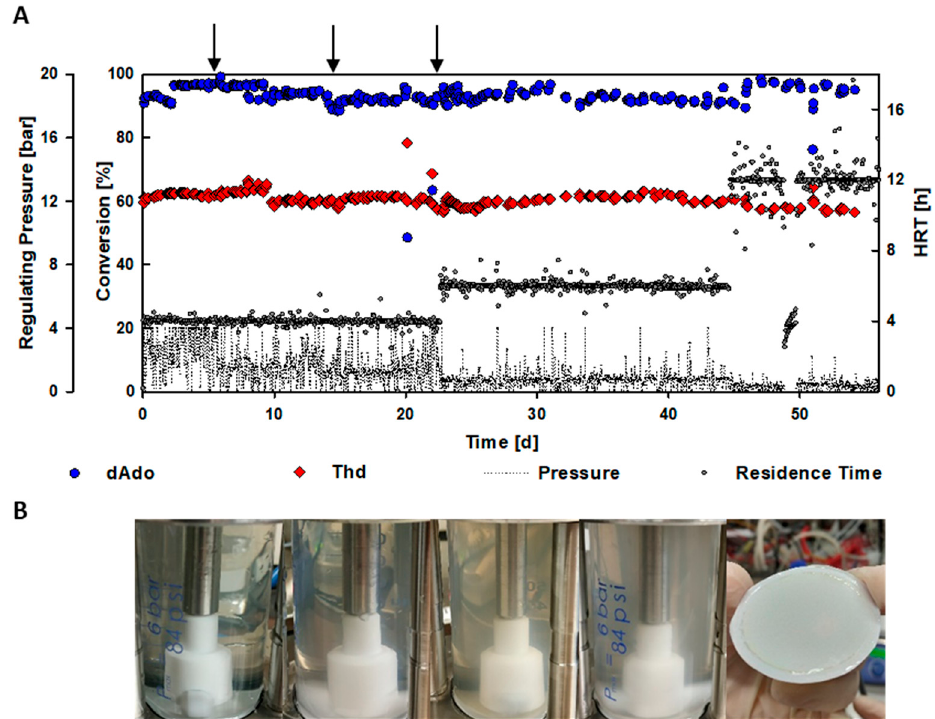
Figure 3. Continuous production of 2 ′ -deoxyadenosine from thymidine (25 mM) and adenine (10 mM) using purified nucleoside phosphorylases (150 U of PyNP 02, 1050 U of PNP 02, by BioNukleo) at 40 °C, stirred at 200 rpm. ( A ) Monitoring of thymidine (Thd) cleavage and 2 ′ -deoxyadenosine (dAdo) formation, and regulating pressure during operation, at hydraulic residence times (HRT) of 4, 6, and 12 h. Membrane exchange and centrifugation of the reactor content, to remove precipitate, is indicated by an arrow. ( B ) Turbidity of the reaction mixture inside the EMR and membrane clogging were observed over the course of the reaction.